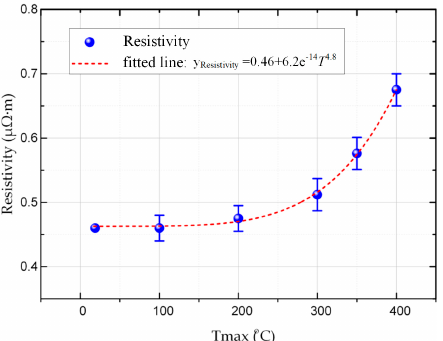
Figure 5. The variation of electrical resistivity with thermal shock temperature after a single thermal shock.